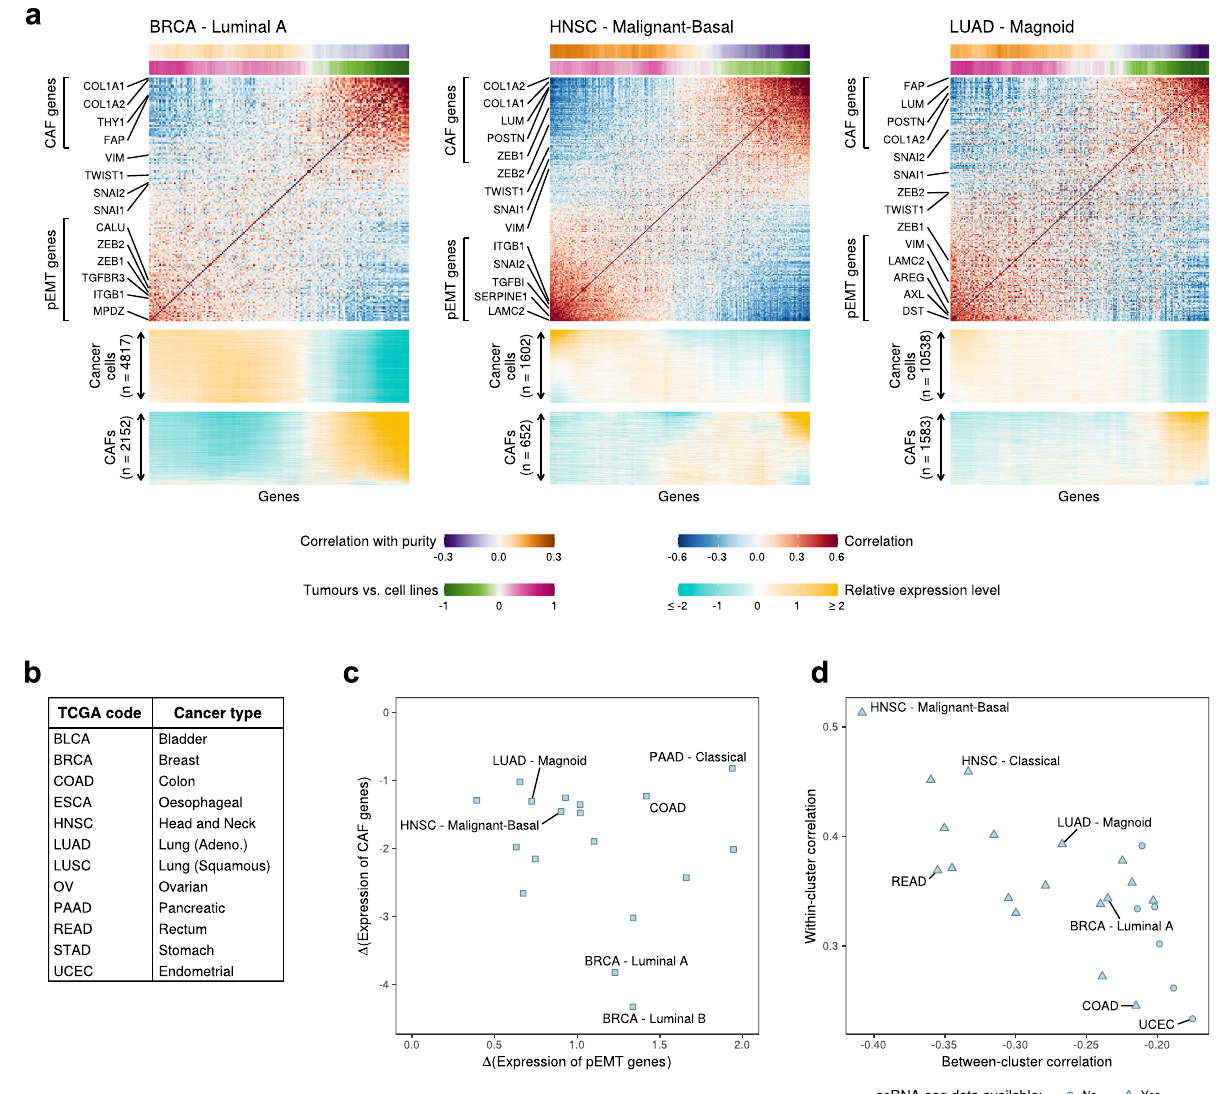
Fig. 3 Deconvolution of cancer and CAF ESG expression from TCGA bulk expression pro fi les. a ESG co-expression matrices derived from TCGA bulk expression data for 3 cancer types of the 24 considered (the remainder are shown in Fig. S10), ordered by the SPIN STS algorithm 37 with slight modi fi cations (see Methods). ESGs are annotated with two colour-coded panels at the top: (1) Pearson correlations with estimates of tumour purity computed by ABSOLUTE 38 ; and (2) comparison of expression levels in tumours versus in cell lines, where positive numbers indicate higher expression in tumours than in cell lines. Heatmaps below the co-expression matrices show the relative expression levels of ESGs in individual CAFs (bottom rows) and cancer cells (top rows) in the relevant scRNA-seq dataset. Selected ESGs are labelled at the side of each co-expression matrix. Source data are provided as a Source Data fi le. b Table of cancer types corresponding to the TCGA disease codes. c Summary scatterplot of the deconvolution results for the 18 cancer types having accompanying scRNA-seq data, showing the difference in average relative expression levels of the top 20 pEMT genes (X-axis) and the top 20 CAF genes (Y-axis) between cancer cells and CAFs. Positive values indicate higher expression in cancer cells and negative values indicate higher expression in CAFs. d Summary scatterplot of the deconvolution results for all 24 cancer types examined, showing for each cancer type the average correlations among genes from the same cluster of ESGs (within-cluster, Y-axis) and between genes from the two different clusters of ESGs (between-cluster,